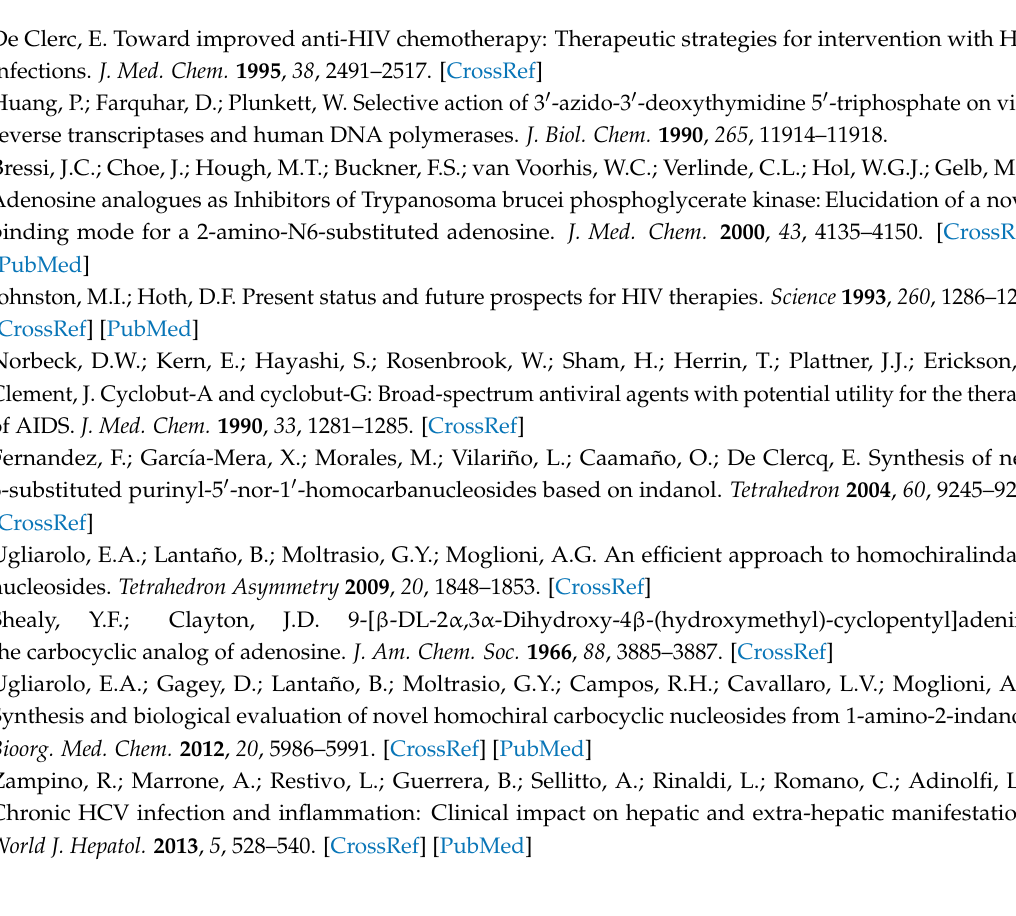
Figure S2: HSQC of compound 5 , Figure S3: NOESY spectrum of compound 5 , Figure S4: Selective nOe of compound 5